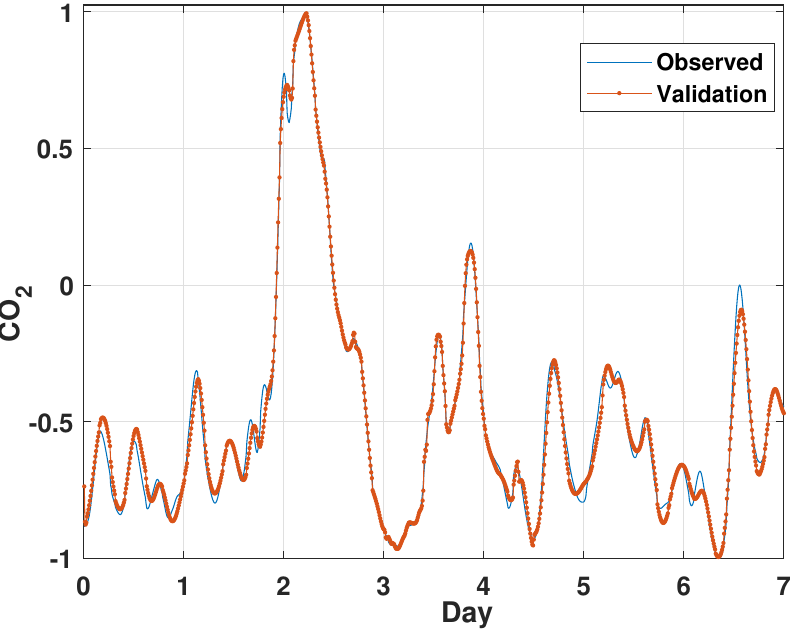
Figure 6. Training and validation of the CO 2 data.